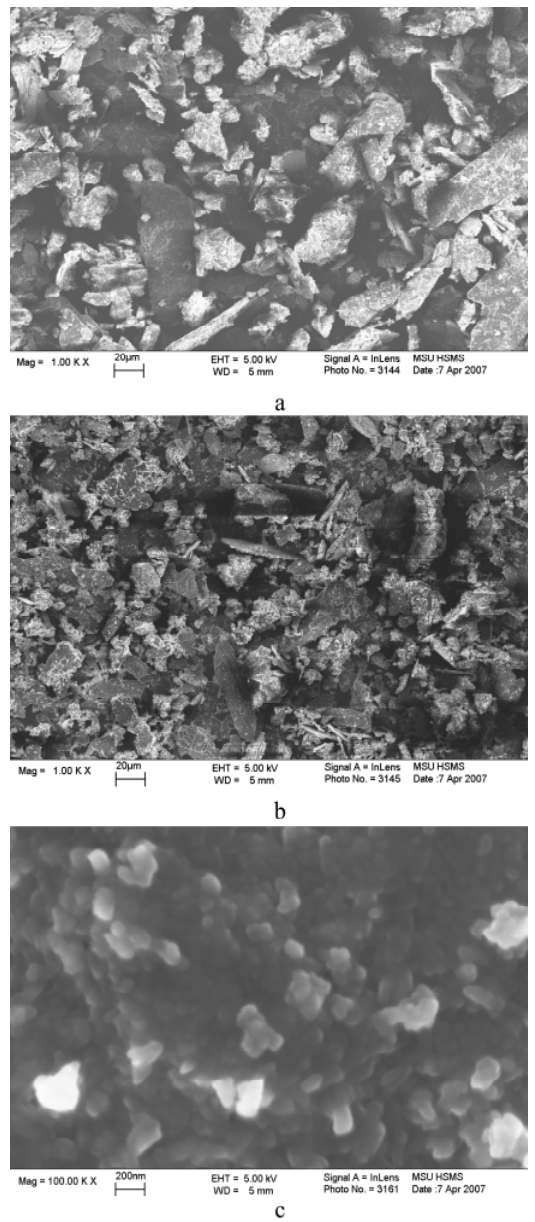
Figure 2. Micrographs of as-precipitated powders from (NH ) HPO and 4 2 4